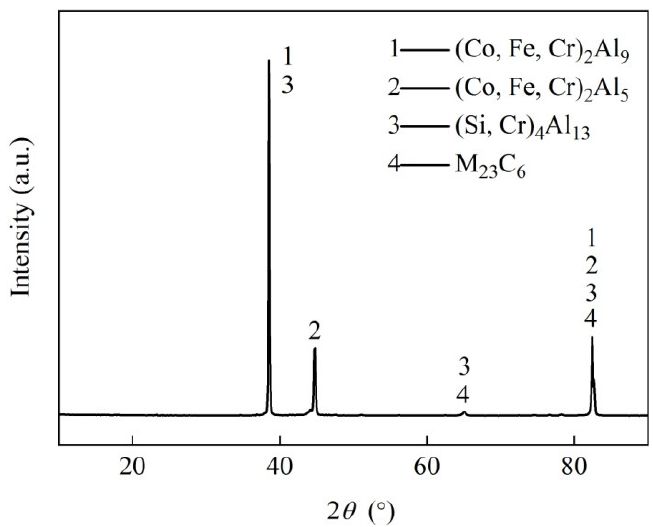
Figure 9. XRD patterns of the intermetallic compounds generated by the Co-based alloy cladding layer immersed in liquid aluminum for 24 h.